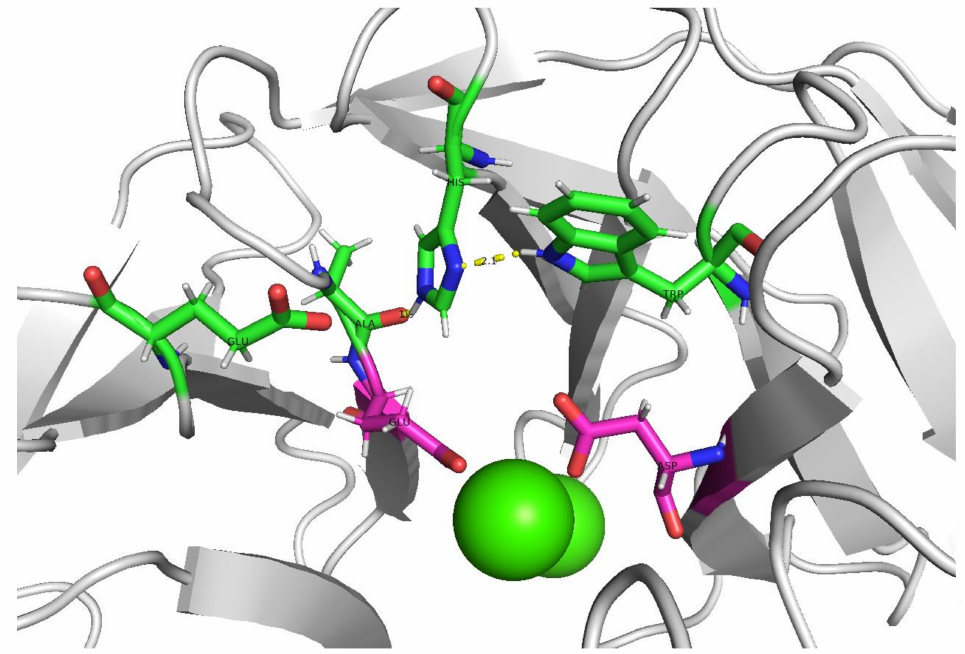
Figure 2. DFPase from Loligo vulgaris (PDB ID 3O4P, resolution 0.85 Å ) [72]: a detailed view of the two possible catalytic residues: (1) Ala20, Glu37, Trp244, and His287 coloured green and (2) Glu21 and Asp229 coloured magenta.